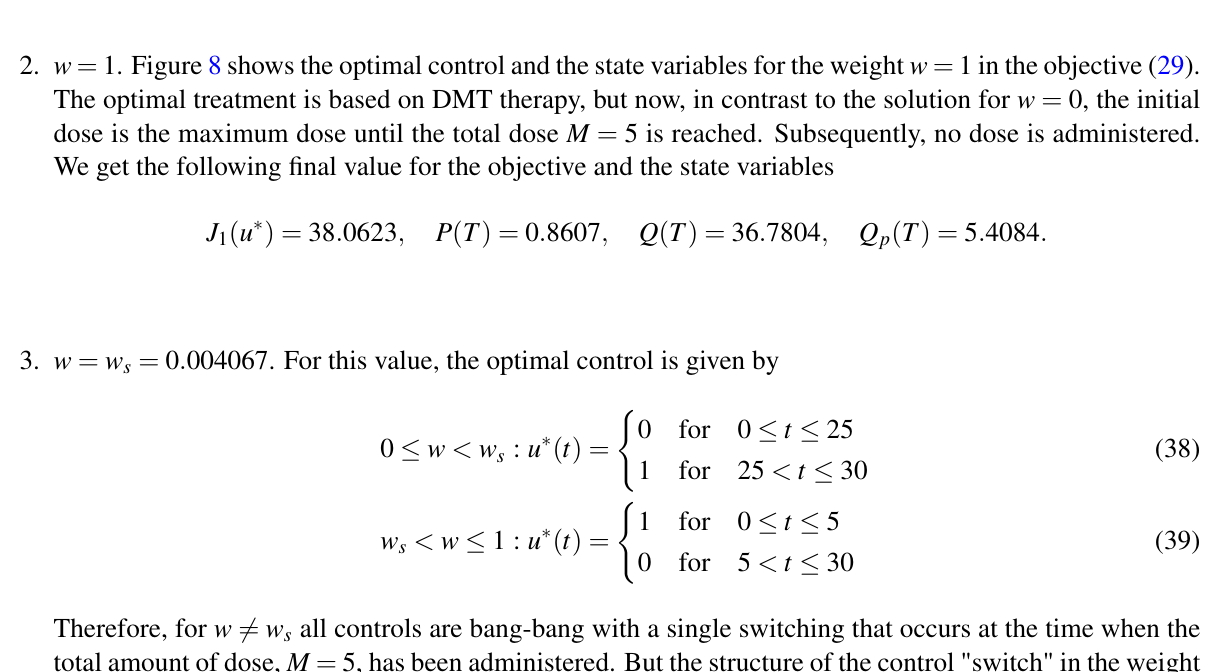
Fig. 8 Optimal solution for functional J w ( u ) in (29) with w = 1 and total dose M = 5; the time horizon is 30 days. Top row : a) proliferative cells P , b) nonproliferative quiescent cells Q ; Bottom row : c) damaged quiescent cells Q p , d) optimal control u ∗ ( t ) and switching function φ